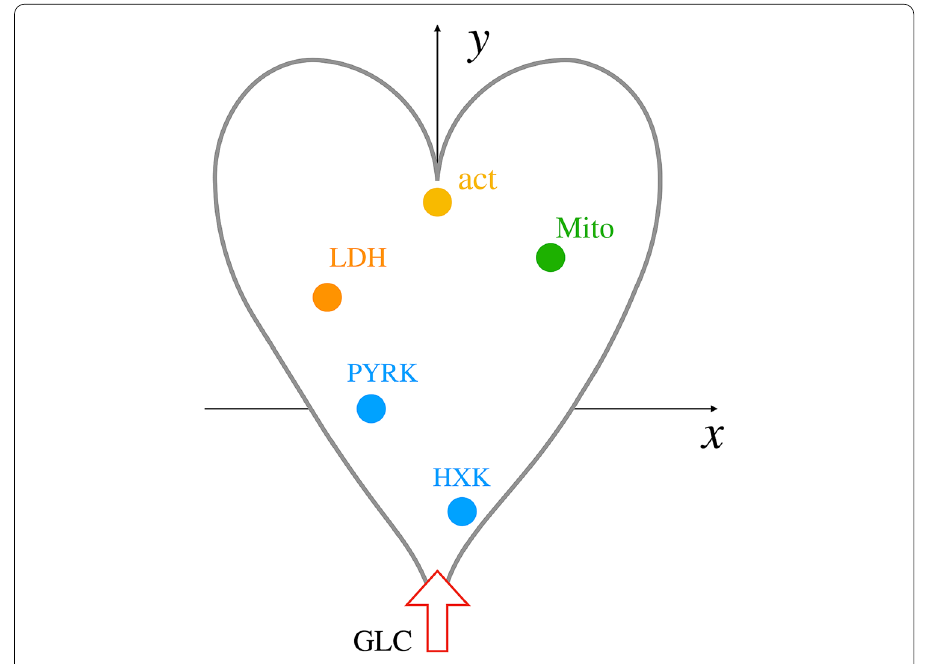
Fig. 9 Location of the chemical reactions Eqs. (1)–(5) and the source term of GLC in the heart shaped